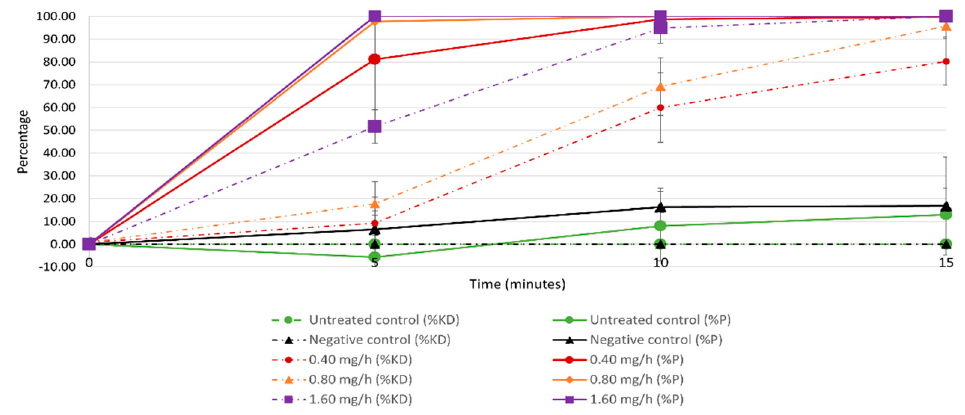
Figure 7. Percent protection (% p ) and knockdown (%KD) over time for Ae. albopictus across the five treatment groups in Experiment 2.